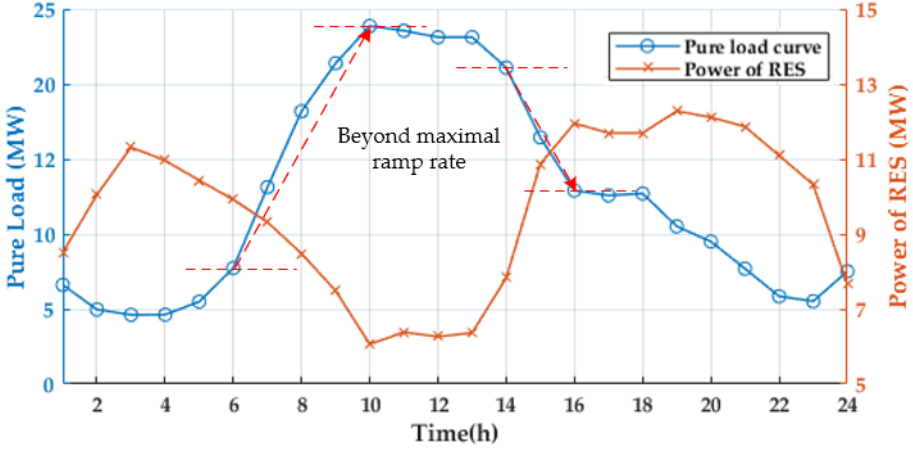
Figure 4. Pure load curve and RES curve.